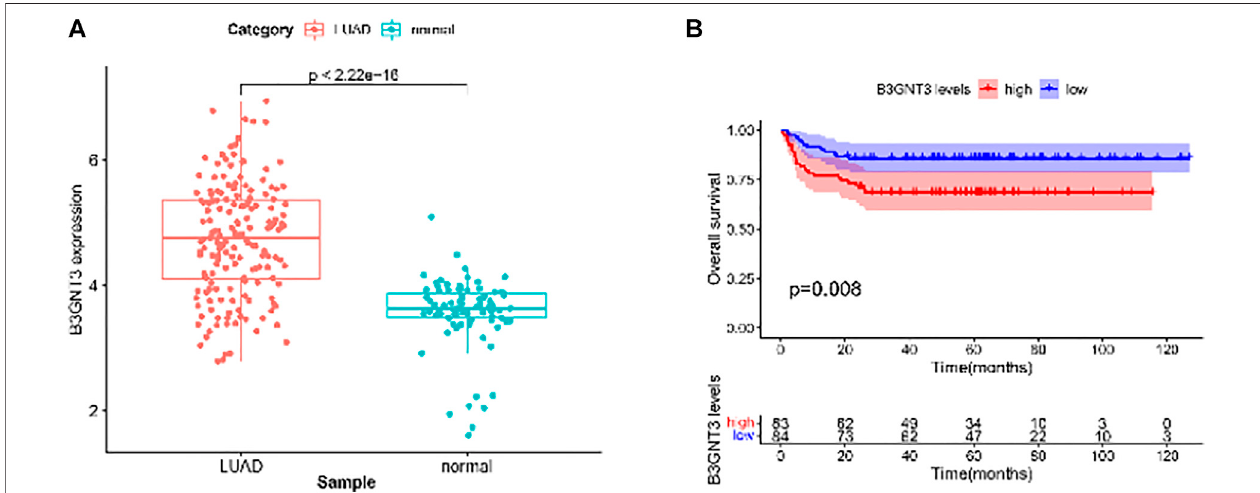
FIGURE 6 | GSE19188 was used to verify the expression levels of 6 hub genes. (A) Gene expression values of B3GNT3. The GSE19188 was used to verify the overall survival (OS) of 6 hub genes. (B) Survival analysis for B3GNT3. The patients were strati fi ed into the high-level group (red) and low-level group (blue) according to the median expression of the gene. Log-rank p < 0.05 was considered to be a statistically signi fi cant difference.